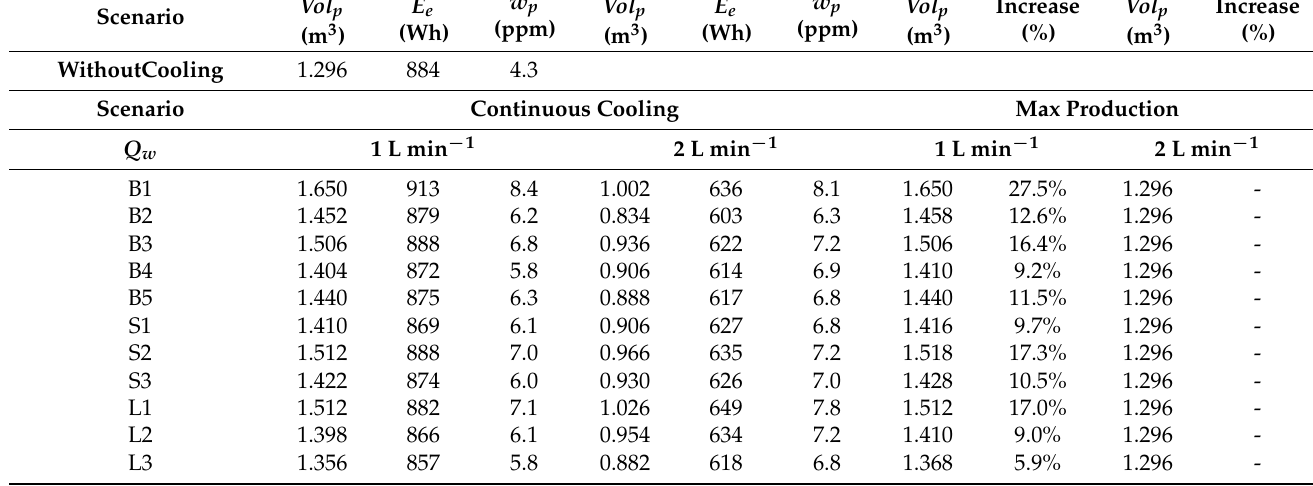
Table 5. Simulation results for PVT-RO hybrid system power generation and water production, based on weather data for 20 October